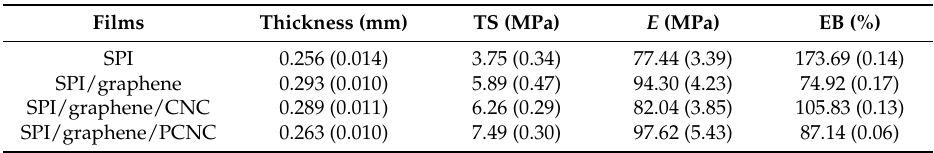
Table 2. Thickness, tensile strength (TS), Young's modulus (E), and elongation at break (EB) of SPI film and SPI-based films modified with graphene, CNC, and PCNC.